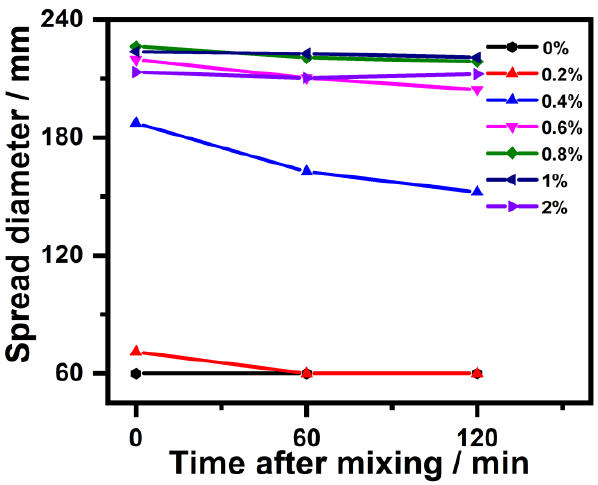
Figure 6. Changes in the spread diameter of NHL pastes with varying IBMA content with time.